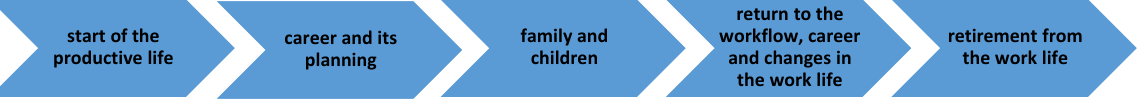
Figure 1. Worker’s lifecycle. Source: (Mathis et al. 2016).